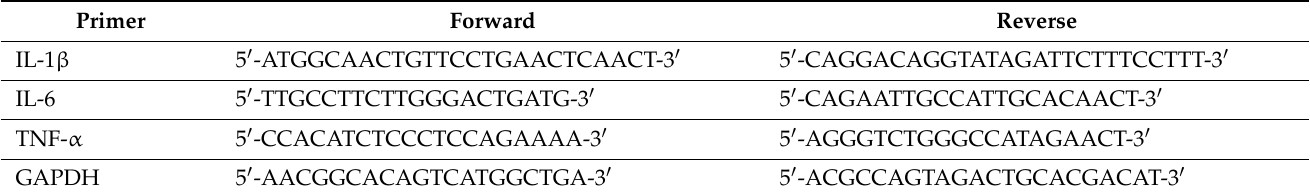
Table 1. Primer sequence used in this